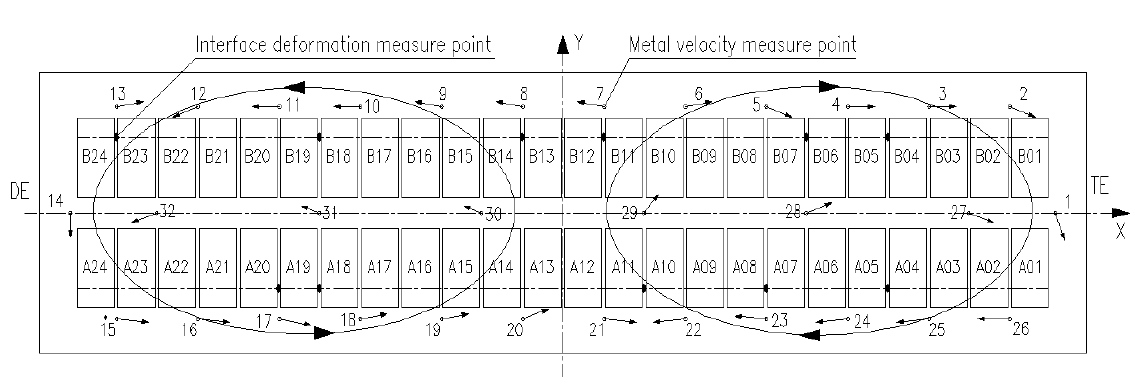
Figure 5. Metal velocity measure points position and flow direction.